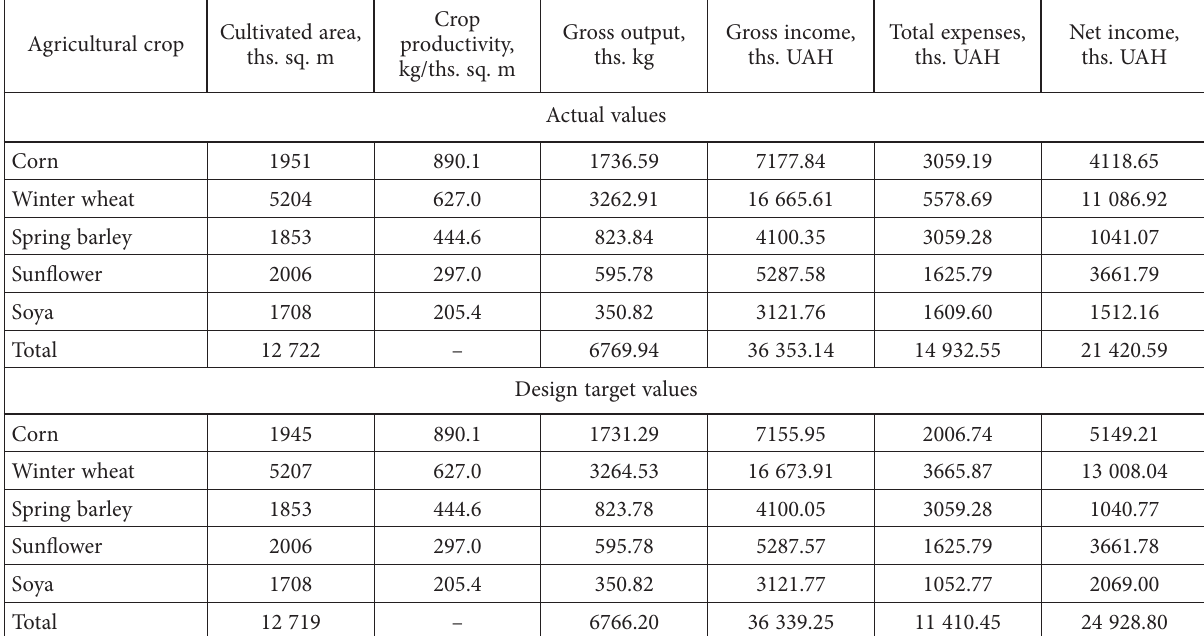
Table 4. Agricultural enterprise land consolidation economic effectiveness (option